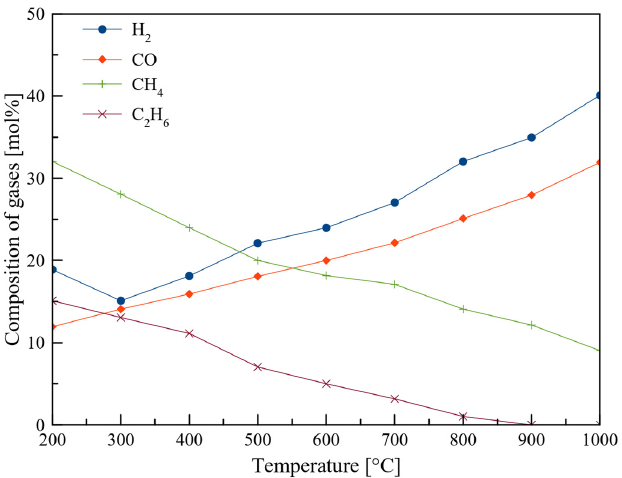
Figure 5. Effect of temperature on the composition of gaseous products from fast pyrolysis of date palm at heating rate of 100 °C/min